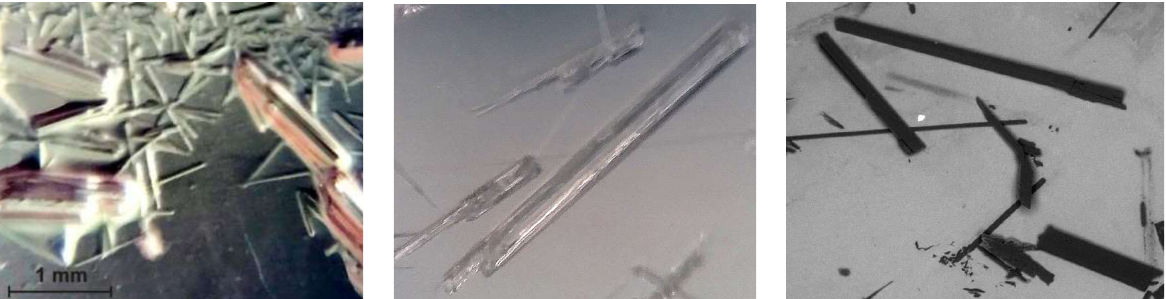
L-lactide crystallizes in needle-shaped crystals from the studied solvent mixture. As other dimensions. Therefore, 1D-PBE should be suitable to describe this system in which the crystal length ( L length ) was chosen as the characteristic dimension.